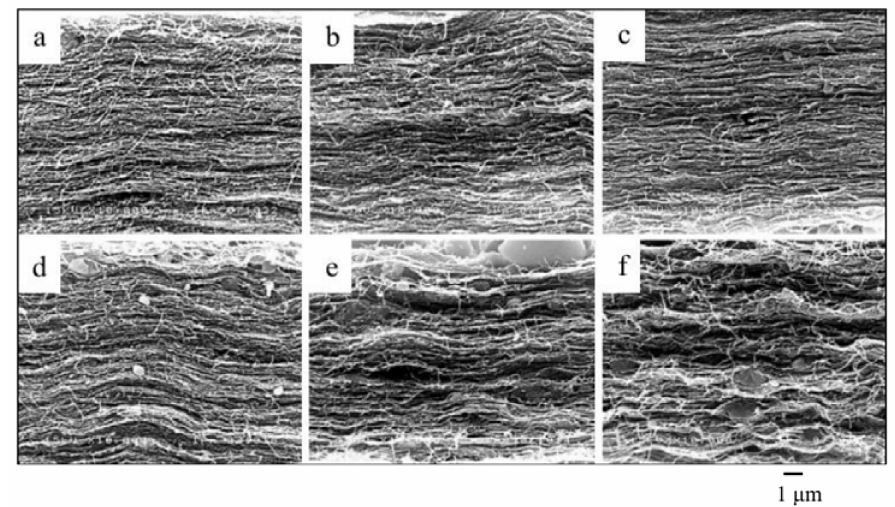
Figure 2. SEM images of cross-sectional morphology of the dried films of BC ( a ), BCC0.2 ( b ), BCC0.4 ( c ), BCC0.6 ( d ), BCC0.8 ( e ), and BCC1.0 ( f ) at the magnification of 10,000 × .